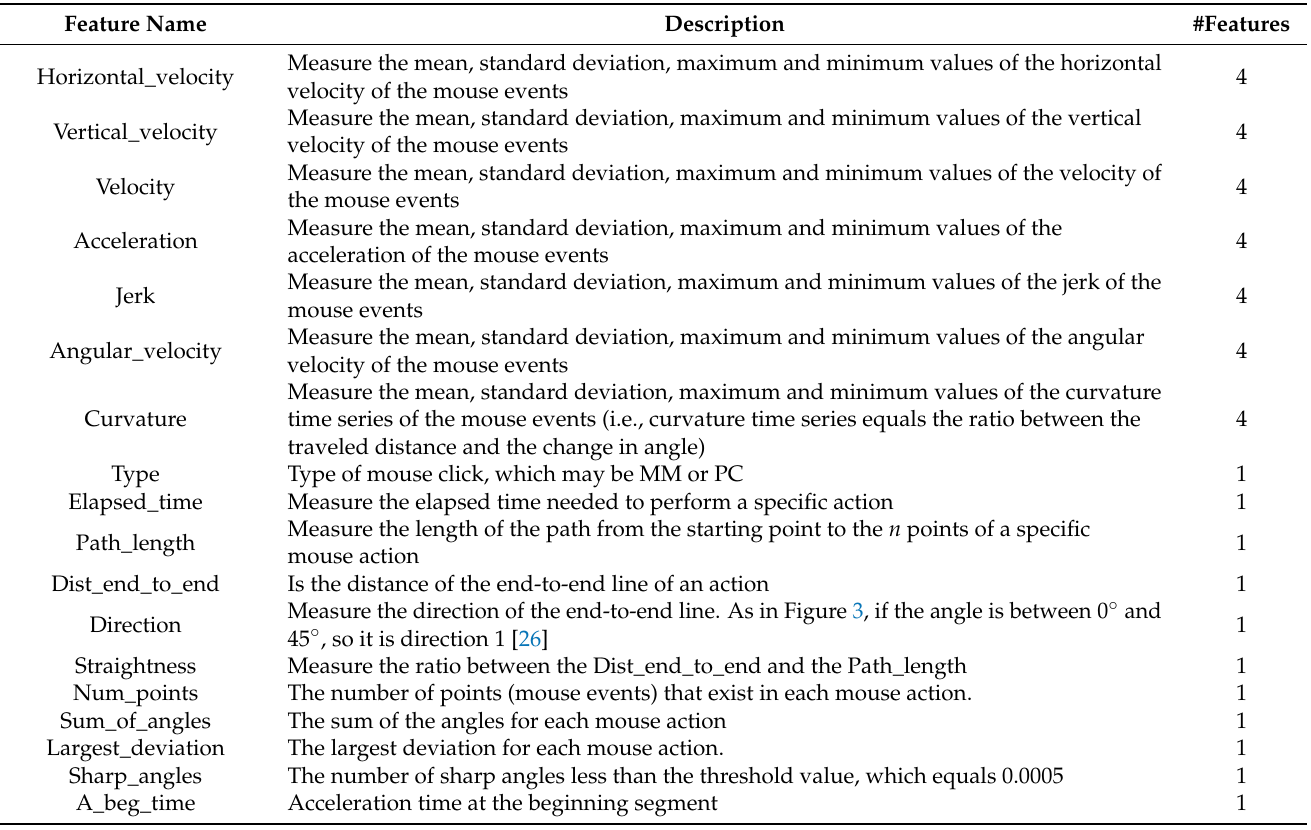
Figure 2. The architecture of the fair assessment module.